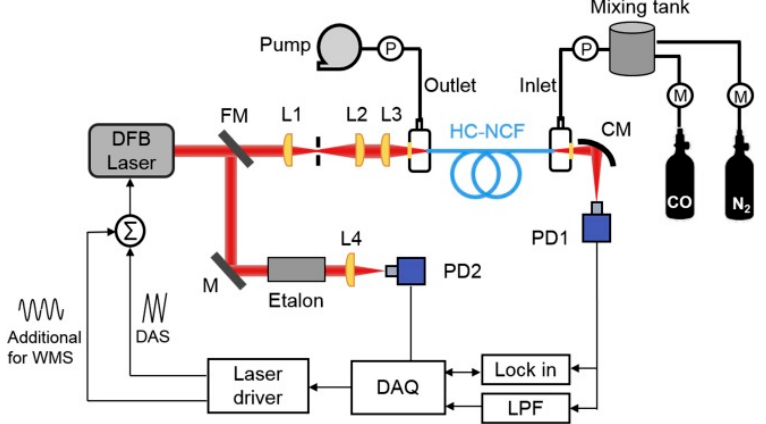
Figure 4. A setup of the CO sensor relying of the use of the TDLAS technique and an ARHCF-based gas absorption cell. L—lenses, M—mirror, CM—concave mirror, FM—flip mirror, P—pressure gauge, LPF—low-pass filter, PD1/PD2—photodetectors, DAQ—data acquisition card. Reprinted from [38] with permission from Elsevier.